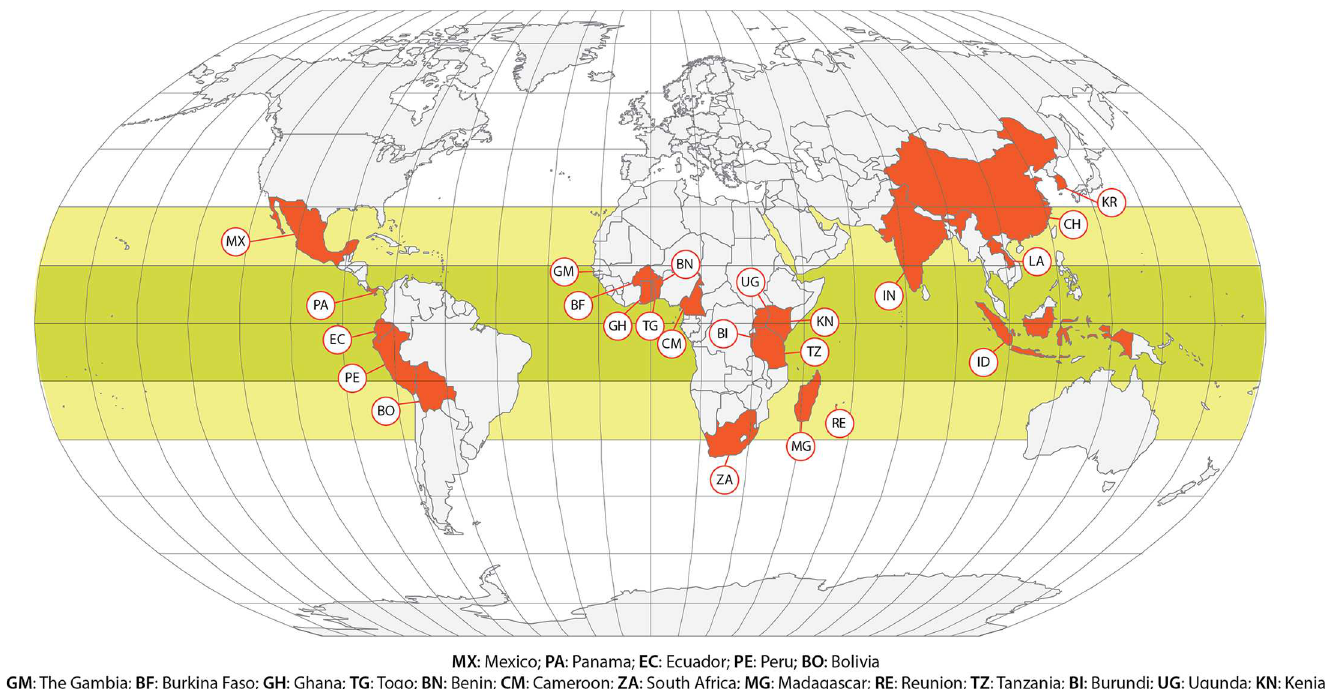
Fig 2. Locations of studies that evaluated association of cysticercosis and